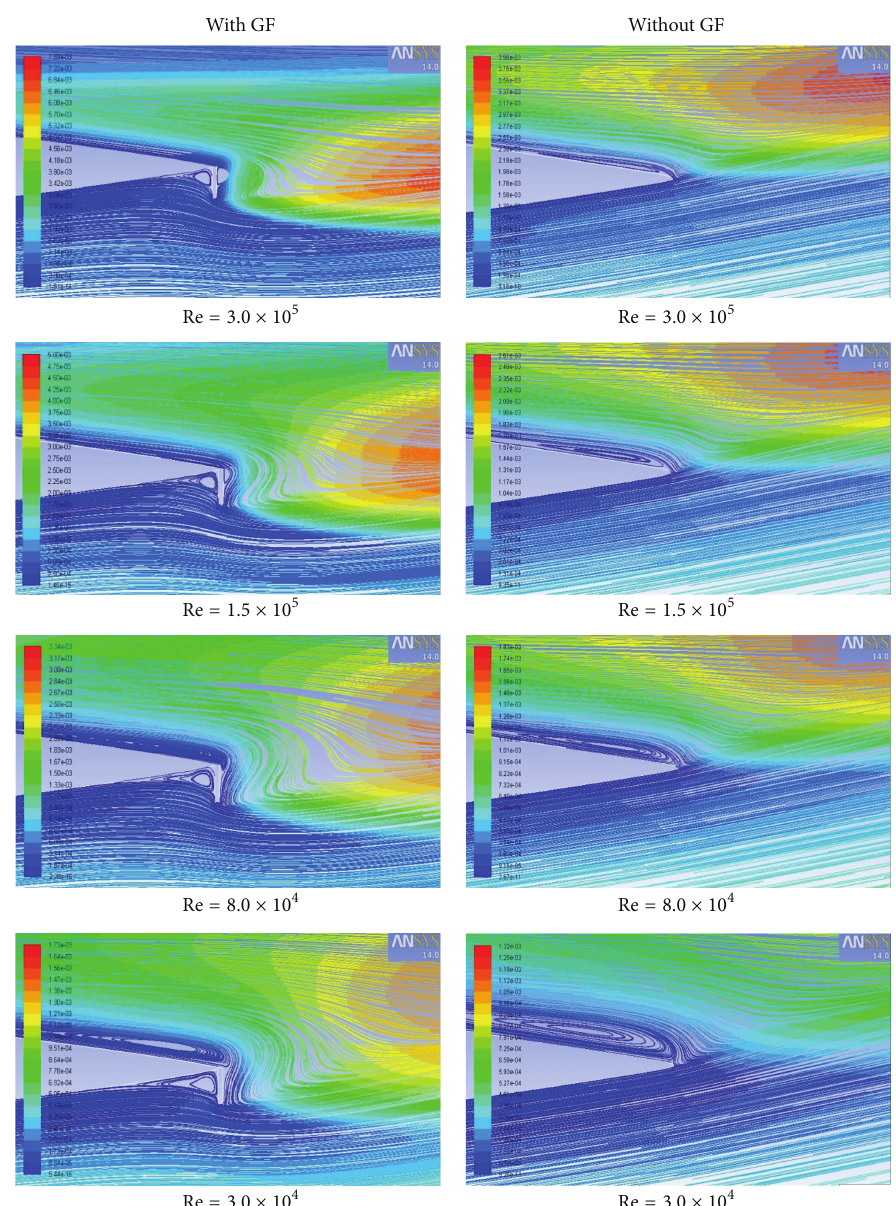
Figure 10: Pathlines and turbulent viscosity for different Reynolds numbers at AoA = 12 ∘ of the airfoil with and without Gurney flap.